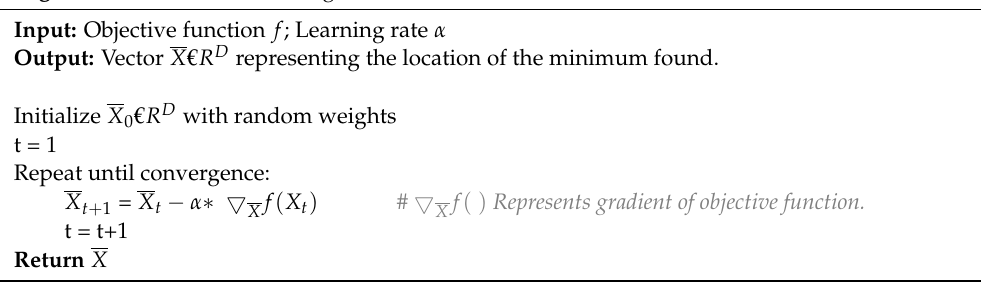
Algorithm 1: Constant Learning Rate